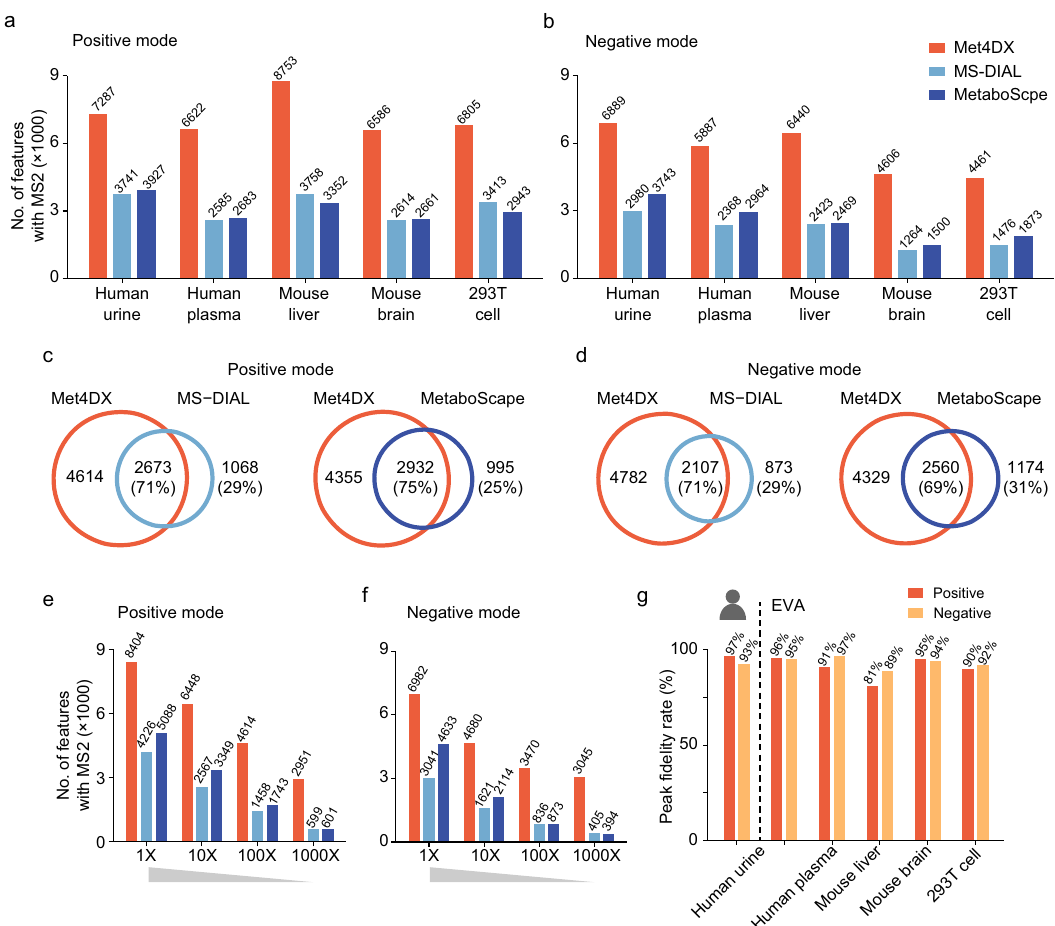
Fig. 3 | Highcoverage andsensitivity of4Dpeak detection. a , b The numbersof 4D peaks with MS2 spectra achieved by different software tools in different bio- logicalsamplesinpositive( a )andnegative( b )modes( n =6technicalreplicatesfor each sample type). c , d Overlaps of 4D peaks in human urine samples detected by different software tools inpositive ( c ) and negative ( d )modes. e , f The numbersof